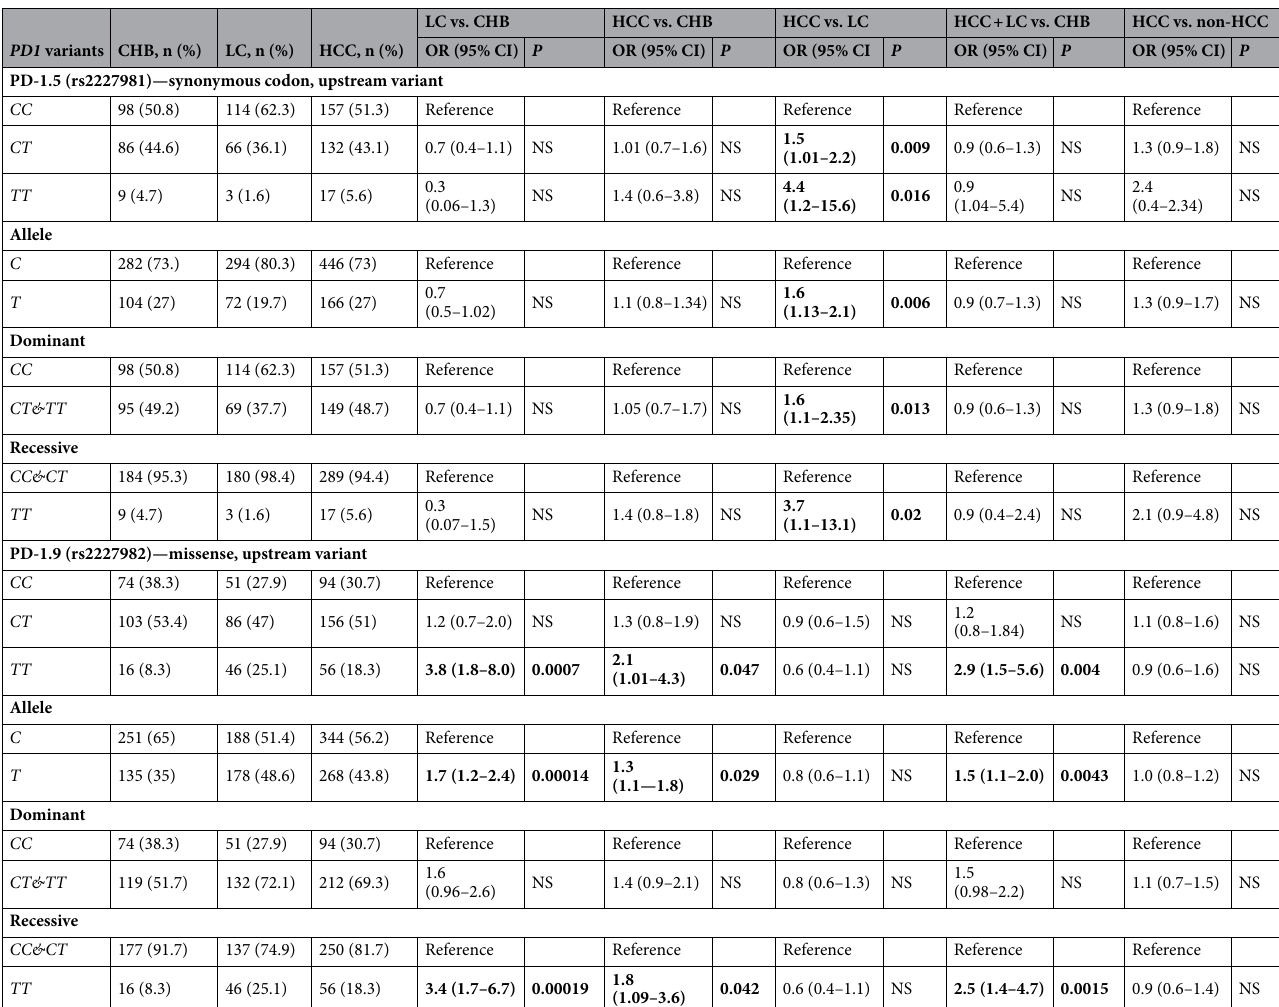
Table 3. Association of PD1 polymorphisms with liver disease progression. ORs and P- values were calculated by using binary logistic regression model adjusted for age and gender. Bold values present the statistical significance. CHB chronic hepatitis B (n = 193), LC liver cirrhosis (n = 183), HCC hepatocellular carcinoma (n = 306), non-HCC CHB + LC, n number of chromosomes, OR odds ratio.